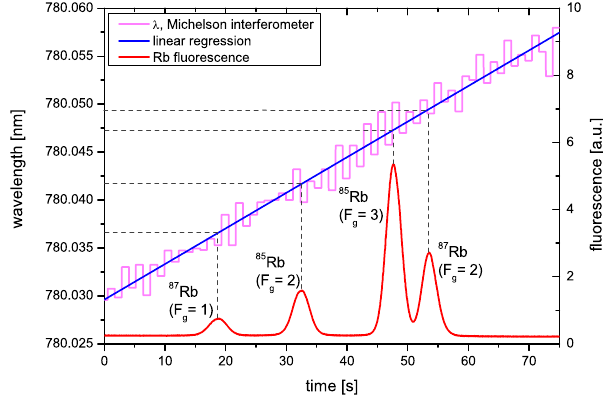
Figure A1. Rubidium spectroscopy using the piezoelectrically tuned TDL (780.030–780.060nm with 0.0004nms − 1 scan speed). The red line depicts the fluorescence light intensity and the vio- let line the Michelson interferometer wavelength measurement. The gray dashed lines denote the measured wavelengths needed to excite the D 2 transitions. With the resolution of our experiment the hyper- fine splitting of the level 5P 3 / 2 is not resolved, while the numbers F g denote the hyperfine levels of 5S 1 / 2